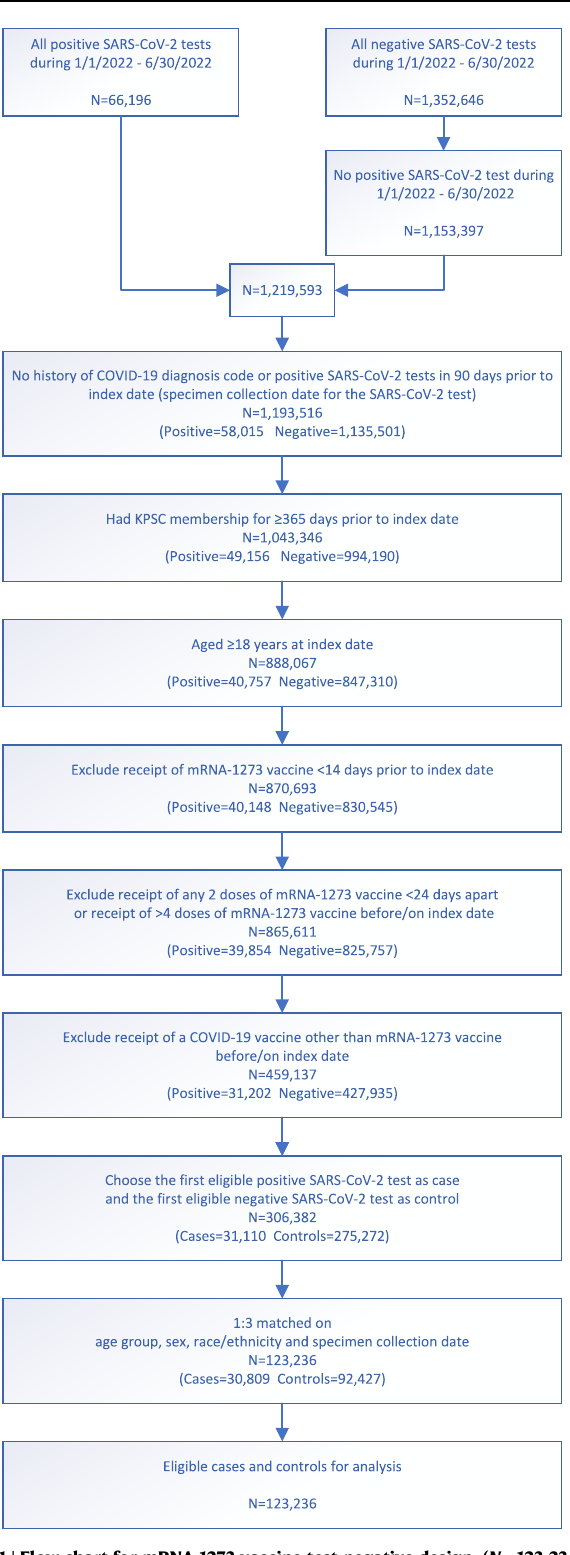
Fig. 1 | Flow chart for mRNA-1273 vaccine test-negative design. ( N =123,236). Steps for selection of30,809 cases and 92,427 controls by inclusion and exclusion criteria, and subsequent matching for vaccine effectiveness estimation. COVID-19 coronavirus disease; KPSC Kaiser Permanente Southern